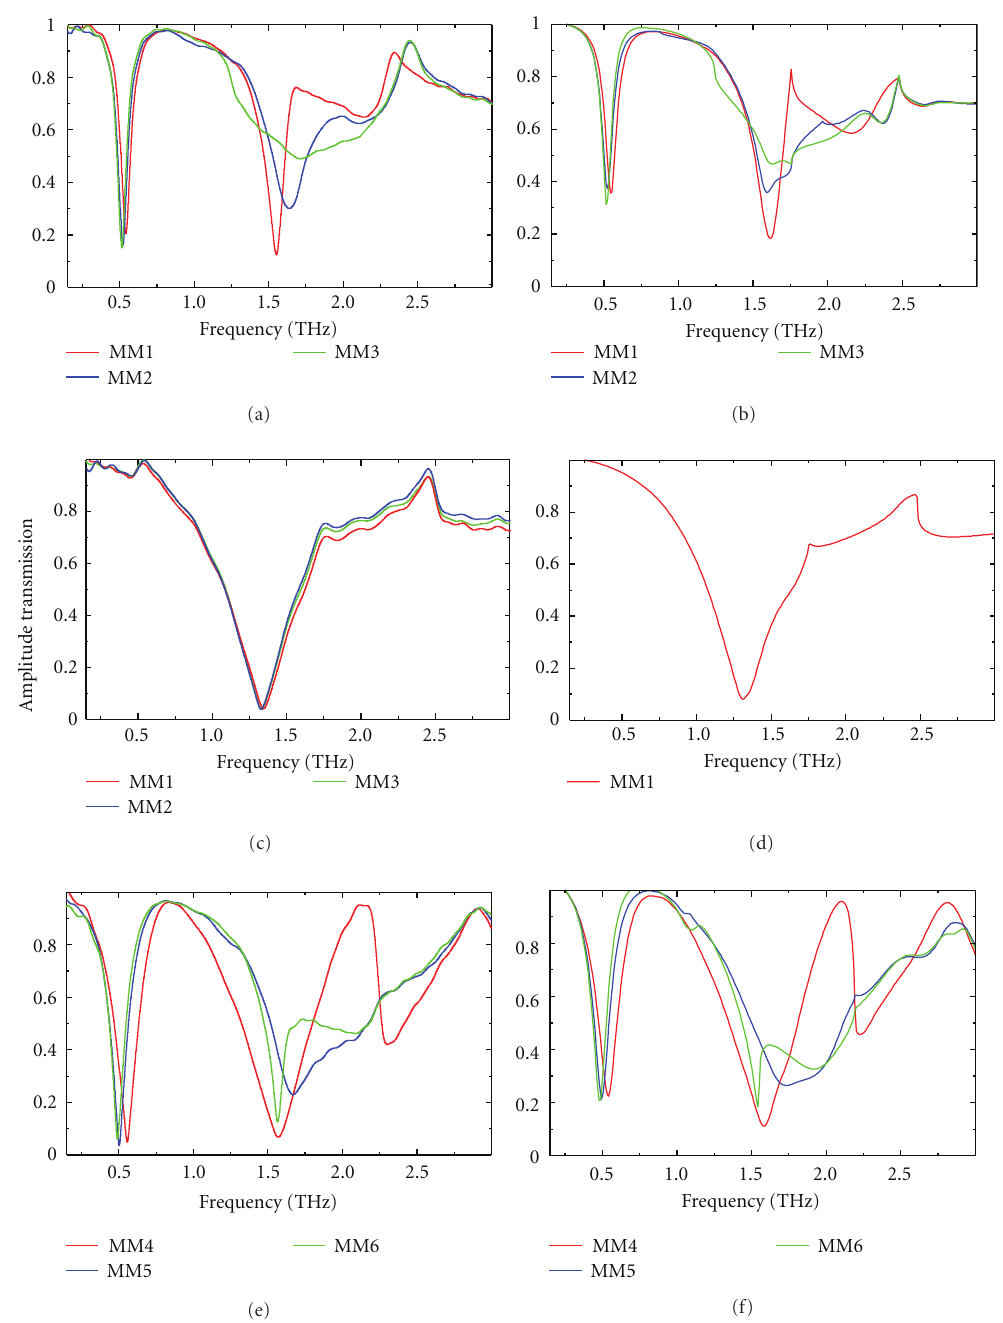
Figure 7: (a), (b) are measurement and simulations of di ff erently oriented metamaterials, MM1, MM2, and MM3, for P = 50 μ m for excitation in x direction, (c), (d) are the same but excitation in y direction, and (e), (f) are measurement and simulations for three di ff erently oriented unit cells with period P = 39 μ